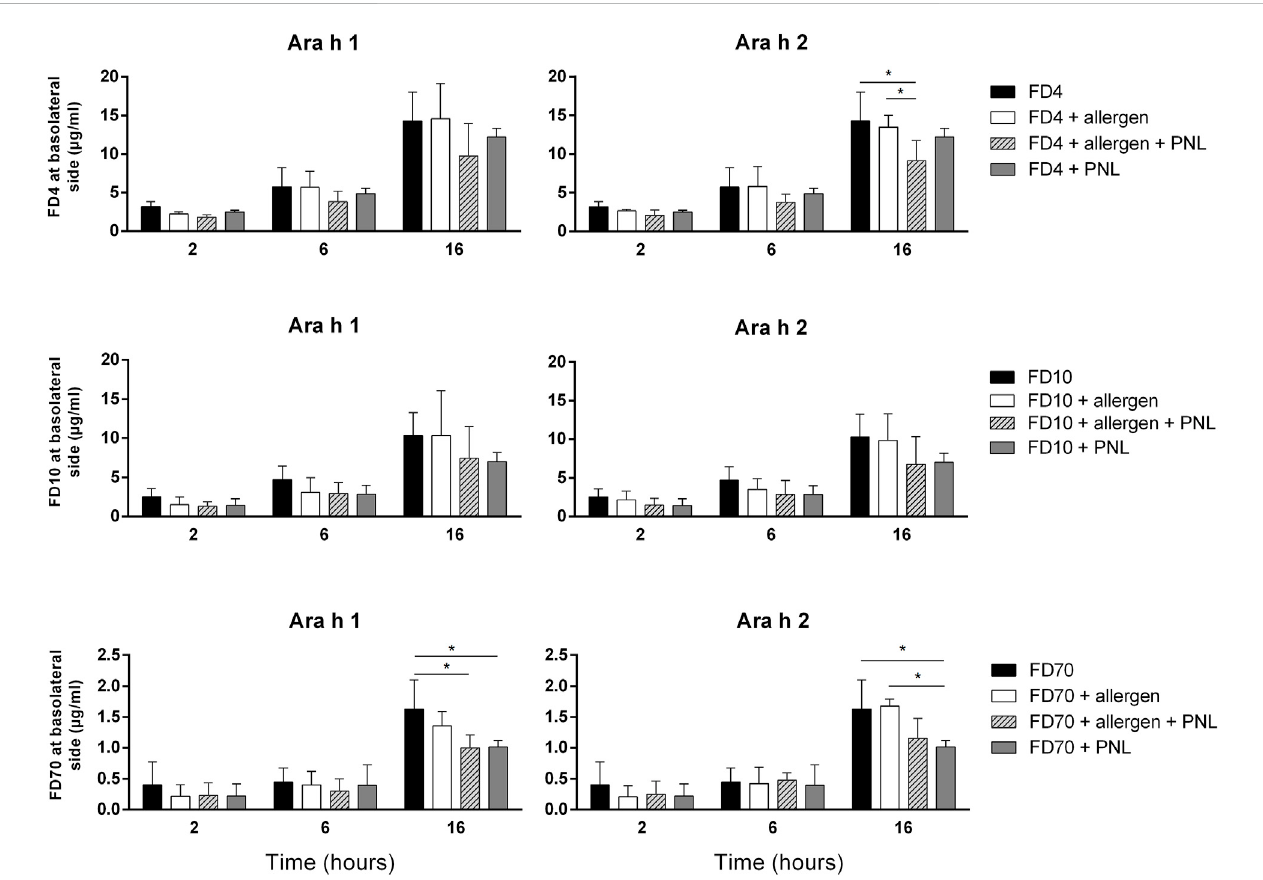
FIGURE 2 Paracellularpermeabilityassay.TransportofFD4,FD10,orFD70throughthecellmonolayer,aloneorincombinationwithArah1,Arah2and/orPNLwas quanti fi ed in basolateral cell culture medium by fl uorometry. Data (mean ± SD of three experiments) show levels of FD after 2, 6, and 16 h of apical